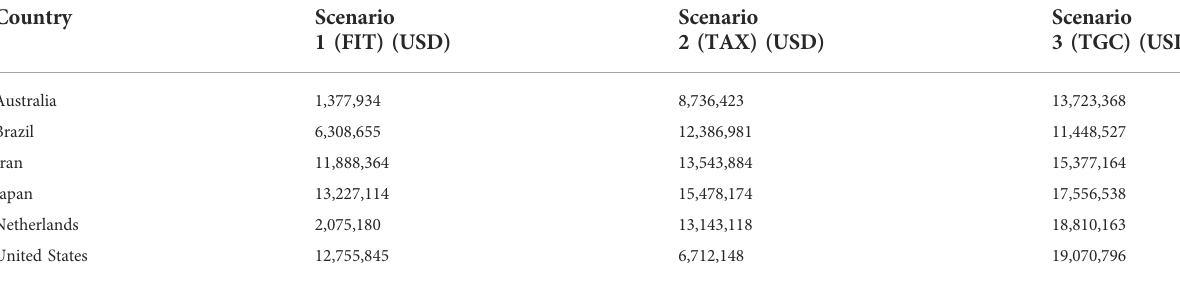
TABLE 10 Investment by the governments.